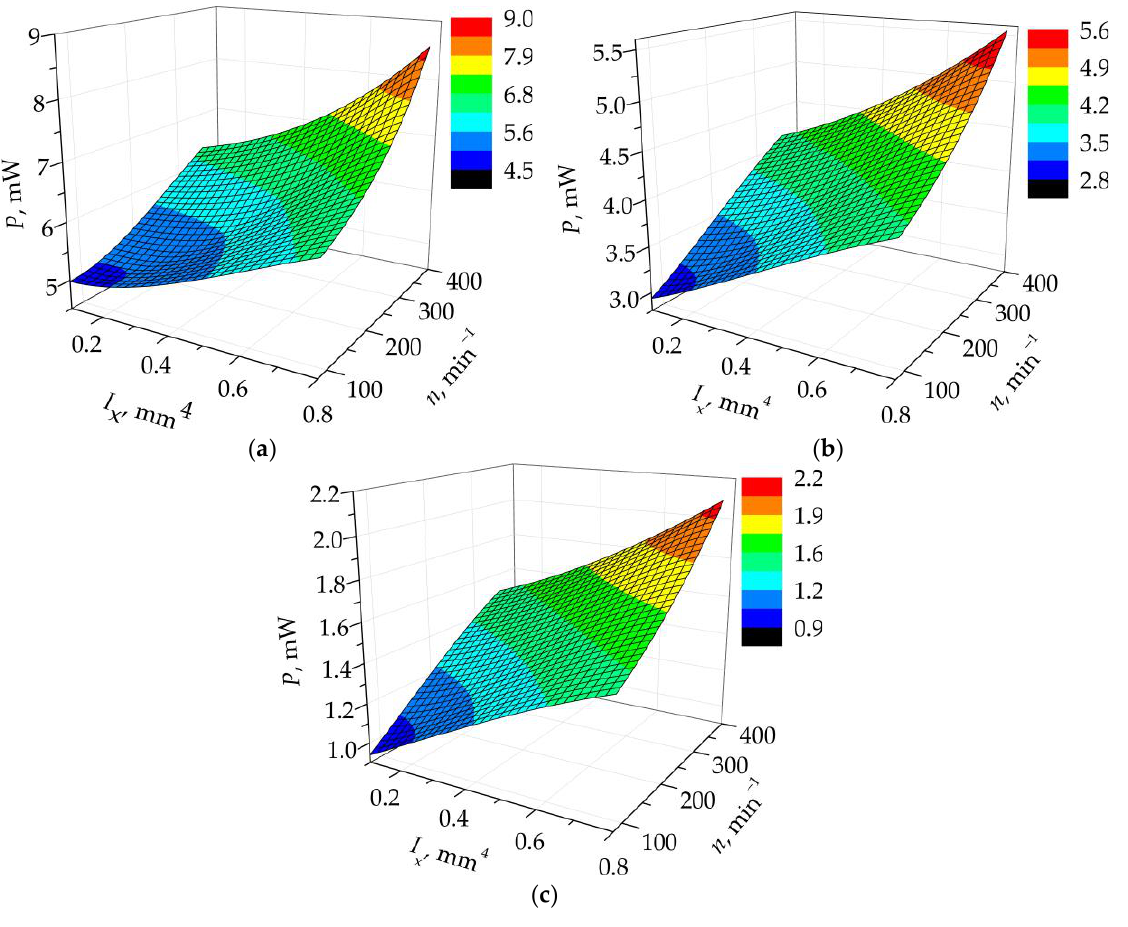
Figure 10. 3D plots representing the effects of the studied design parameters on the responses of the plucked PEH for l = 5 mm: P p-p_max ( a ), P ave_5 ( b ) and P ave_0.04 ( c